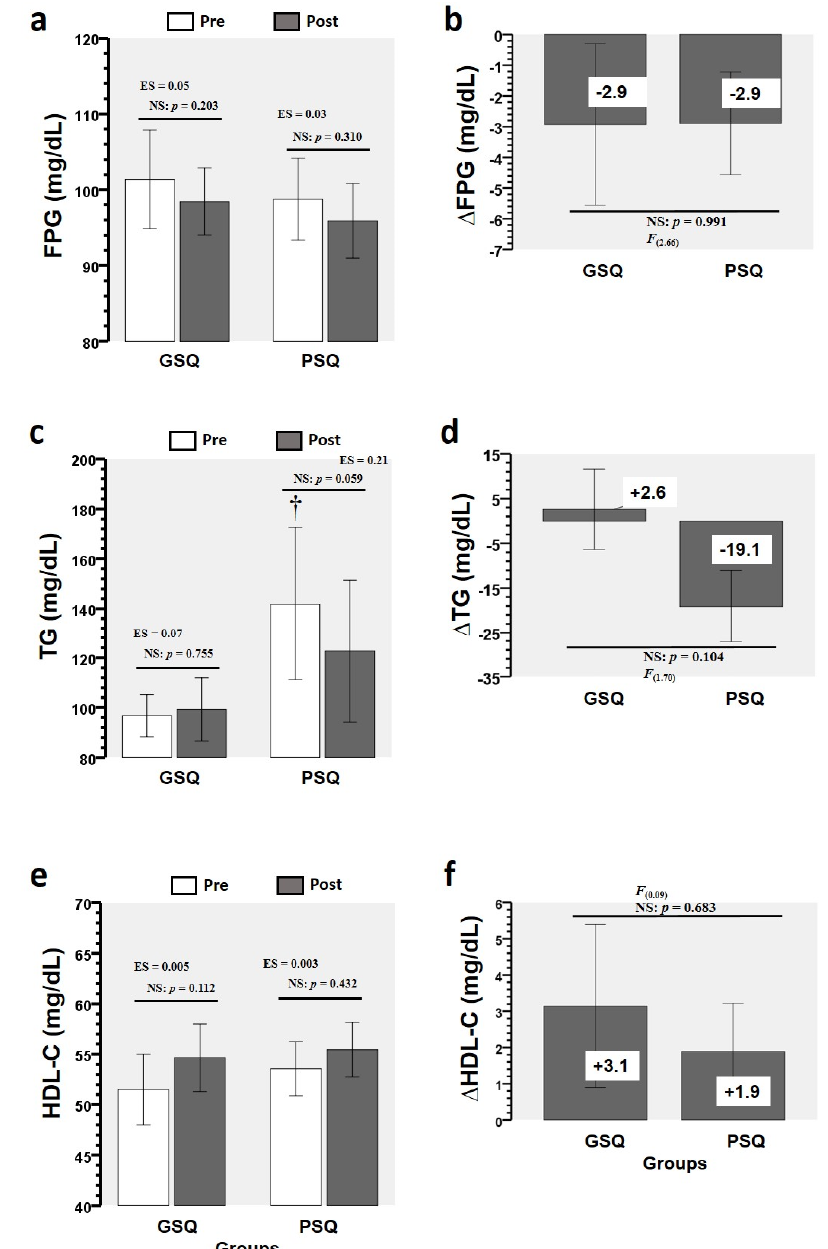
Figure 3. Changes in metabolic syndrome makers for each sleep-quality group. ( ∆ ) denotes delta changes from pre to post intervention. Abbreviations: FPG, fasting plasma glucose; GSQ, good sleep quality; HDL-C, high-density lipoprotein cholesterol; LDL-C, low-density lipoprotein cholesterol; PSQ, poor sleep quality; TC, total cholesterol; TG, triglycerides. ( † ) denotes significant baseline di ff erences ( p < 0.05). (NS) denotes no significant di ff erences. (ES) denotes e ff ect size. (F) denotes the Levene test. Comparing pre- and post-intervention values in GSQ and PSQ groups, there were no changes in FPG, TG, and HDL-C measures ( a , c , e ), and there were no time × group interactions for the ∆ FPG ( b ), ∆ TG ( d ), and ∆ HDL-C ( f )